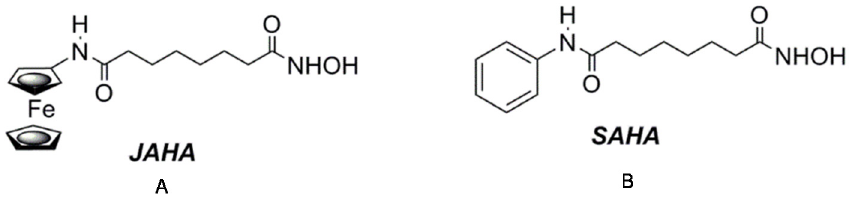
Figure 1. N 1 -(ferrocenyl)-N 8 -hydroxyoctanediamide (JAHA) ( A ) and suberoylanilide hydroxamic Figure 1. N 1 ‐ (ferrocenyl) ‐ N 8 ‐ hydroxyoctanediamide (JAHA) ( A ) and suberoylanilide hydroxamic acid acid (SAHA) ( B ) deacetylase inhibitors (SAHA) ( B ) deacetylase inhibitor (HDACi).